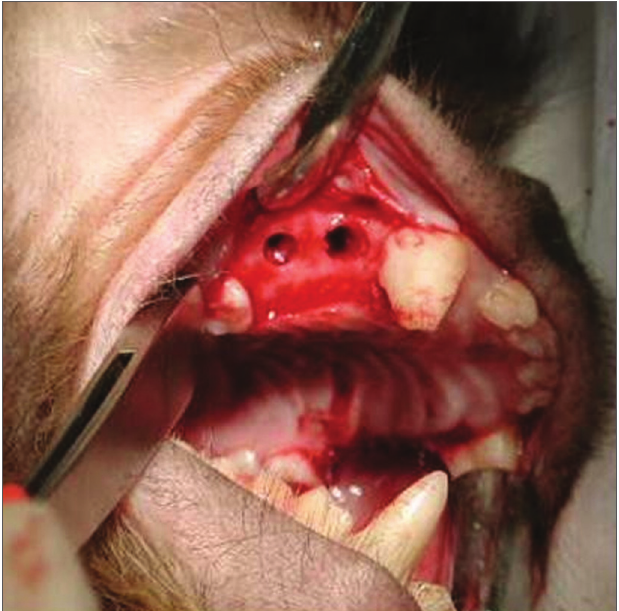
Figure 3. Perforations communicating with the maxillary sinus.